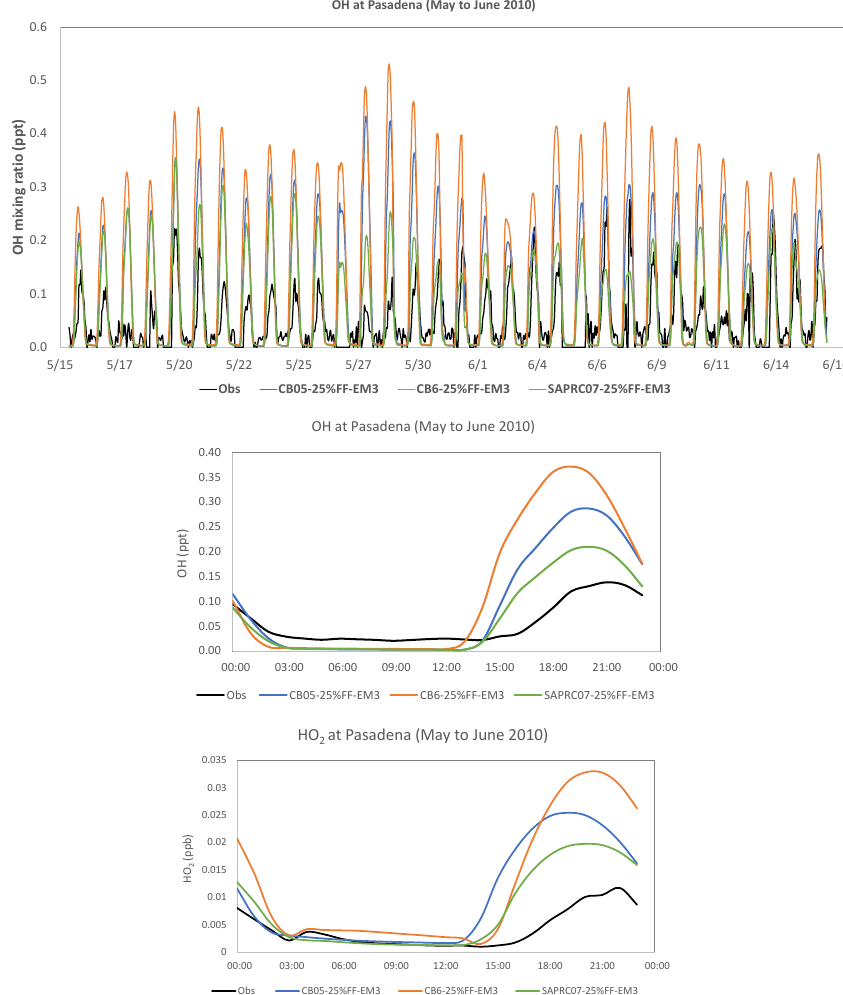
Figure 5. Time series of OH and diurnal plots of OH and HO 2 at Pasadena, CA, during CALNEX, 2010.